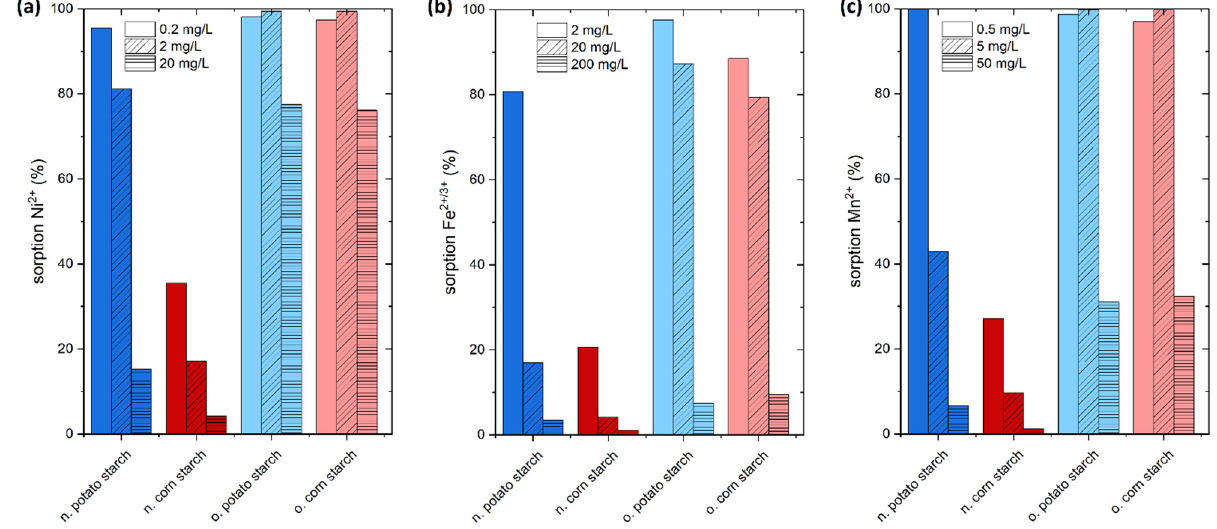
Figure 3. Preliminary sorption experiments of the heavy metal ions Ni 2+ , Fe 2+/3+ , Mn 2+ . ( a ) Sorption of Ni 2+ from NiSO 4 with low concentration of Ni 2+ 0.2 mg/L, medium concentration 2 mg/L and high concentration 20 mg/L. ( b ) Sorption of Fe 2+/3+ from FeSO 4 with low concentration of Fe 2+/3+ 2 mg/L, medium concentration 20 mg/L, and high concentration 200 mg/L ( c ) Mn 2+ from MnSO 4 with low concentration of Mn 2+ 0.5 mg/L, medium concentration 5 mg/L, and high concentration 50 mg/L. The pH of this experiment fluctuates between 7.2 and 4.5. The initial and equilibrium pH values of these experiments were ranging from 7.0 and 5.0. The pH diagrams of the experiments are presented in Figures S1–S3.